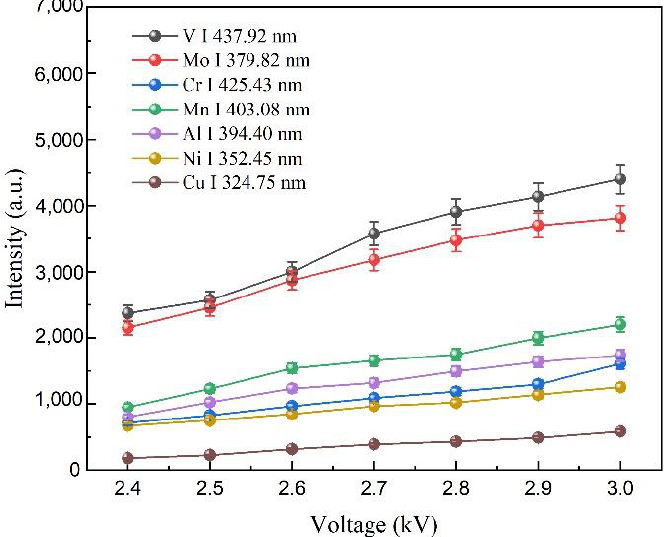
Figure 3. Seven atomic line intensities of V I 427.92 nm, Mo I 379.82 nm, Cr I 425.43 nm, Mn I 403.08 nm, Al I 394.40 nm, Ni I 352.45 nm, and Cu I 324.75 nm observed in fs LA-SIBS while using different discharge voltages.